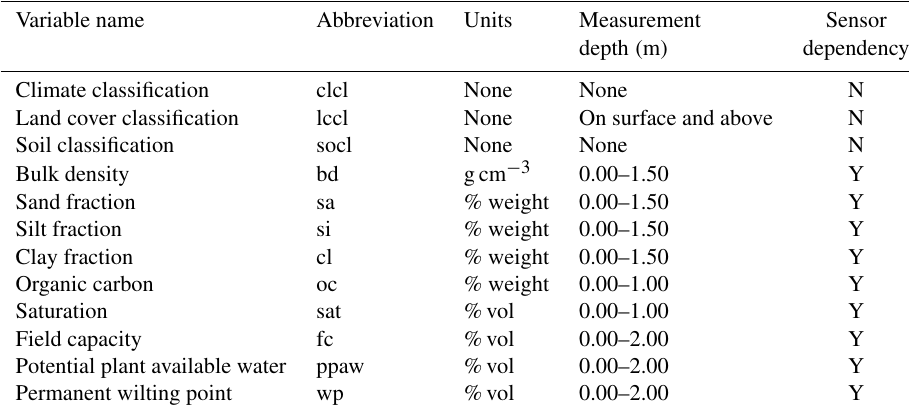
Table 2. Overview of all available temporally static variables stored in the ISMN